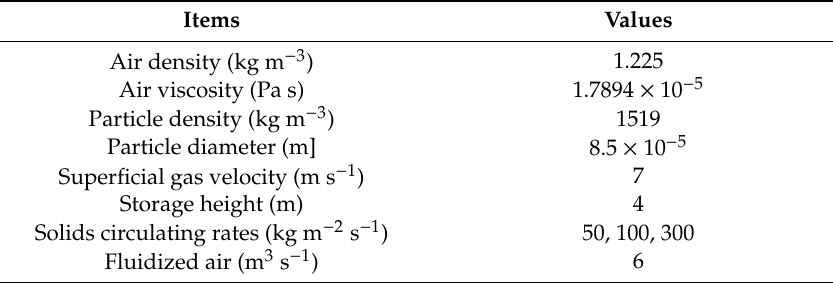
Table 1. Material properties and operating conditions.